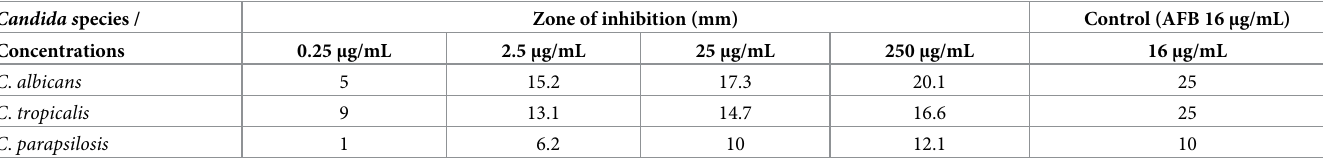
Table 4. Antifungal activity of green propolis extract against Candida species as determined by the disk diffusion assay. Candida s pecies / Zone of inhibition (mm)